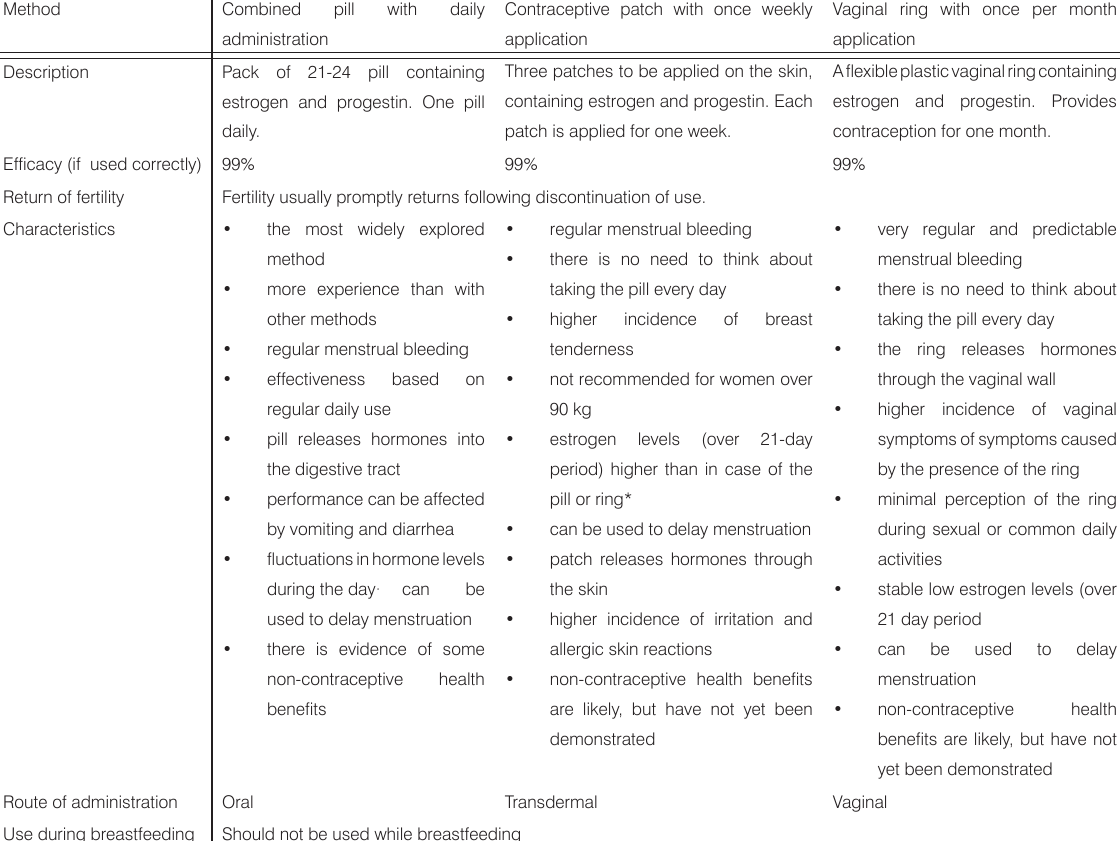
Table 1. Methods of combined hormonal